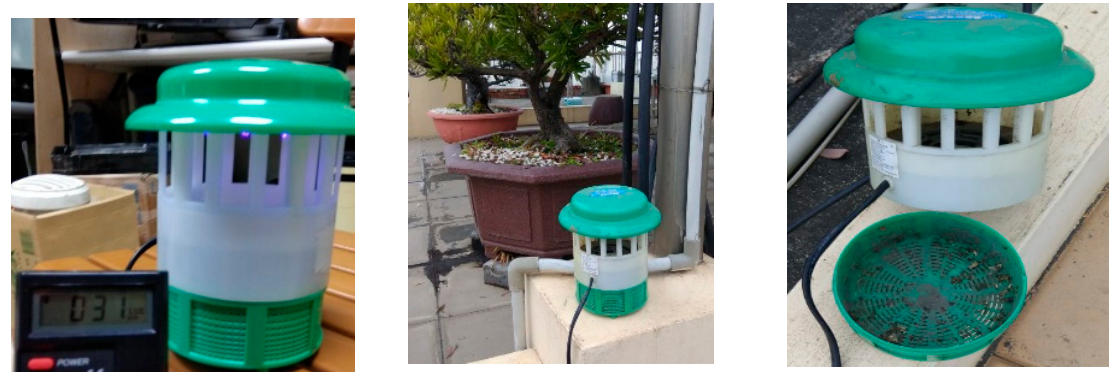
Figure 10. Conventional mosquito trapper and its mosquito trapping results.